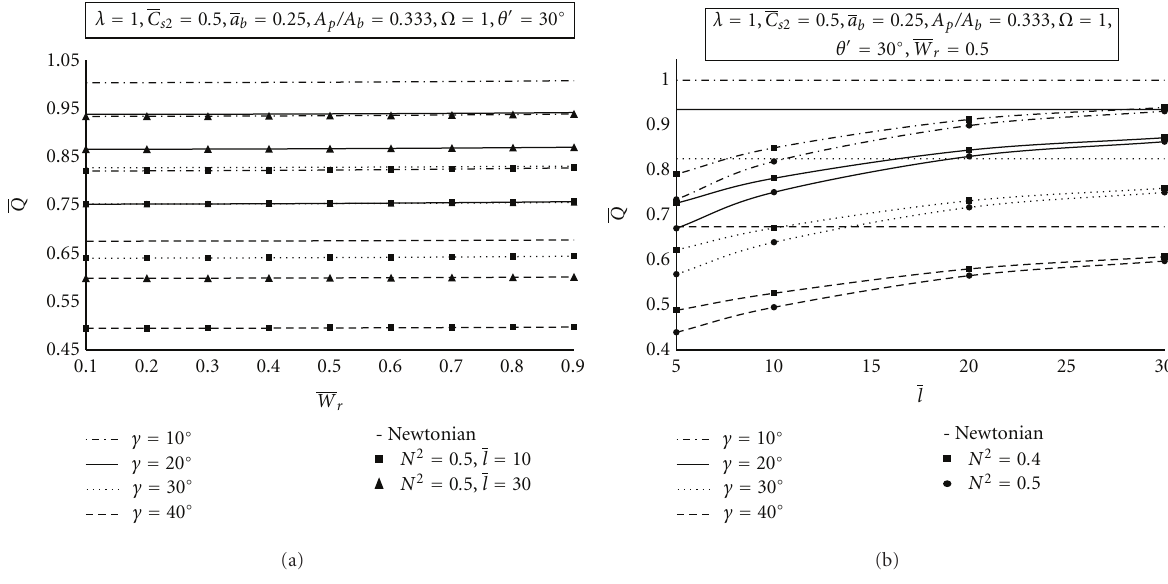
Figure 8: (a) Variation of Q versus radial load W r . (b) Variation of Q versus characteristic length l .